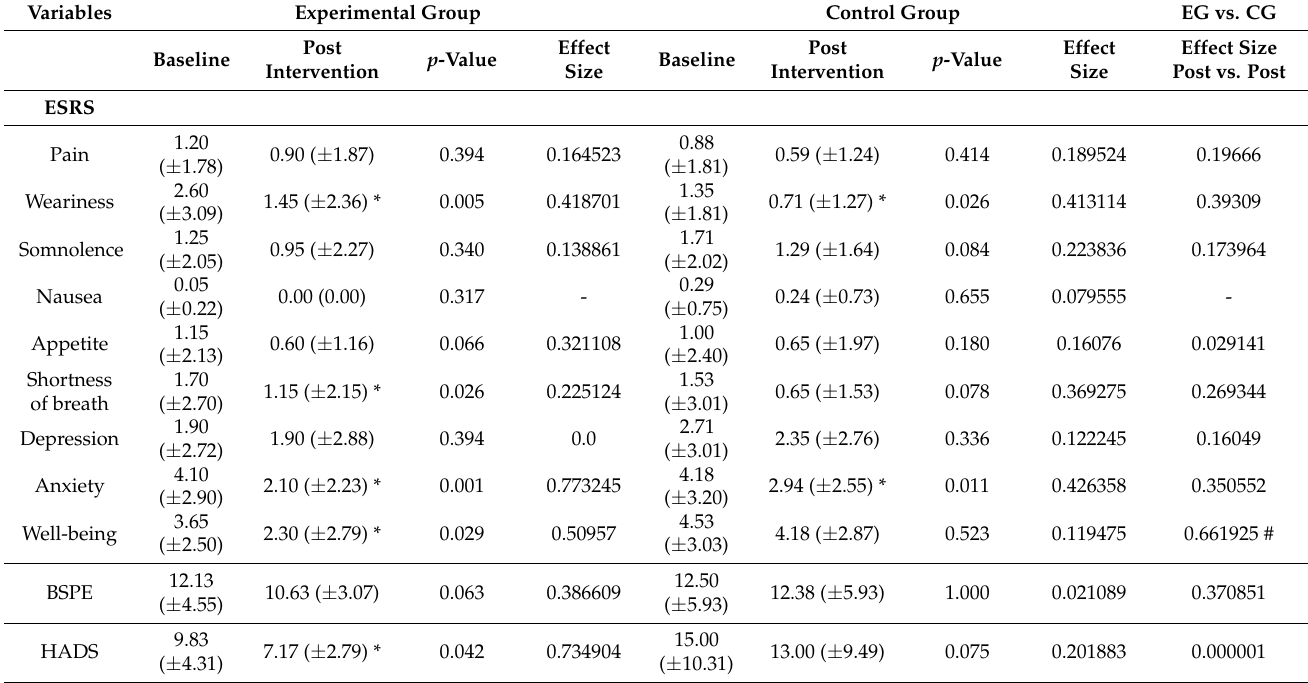
Table 2. Primary